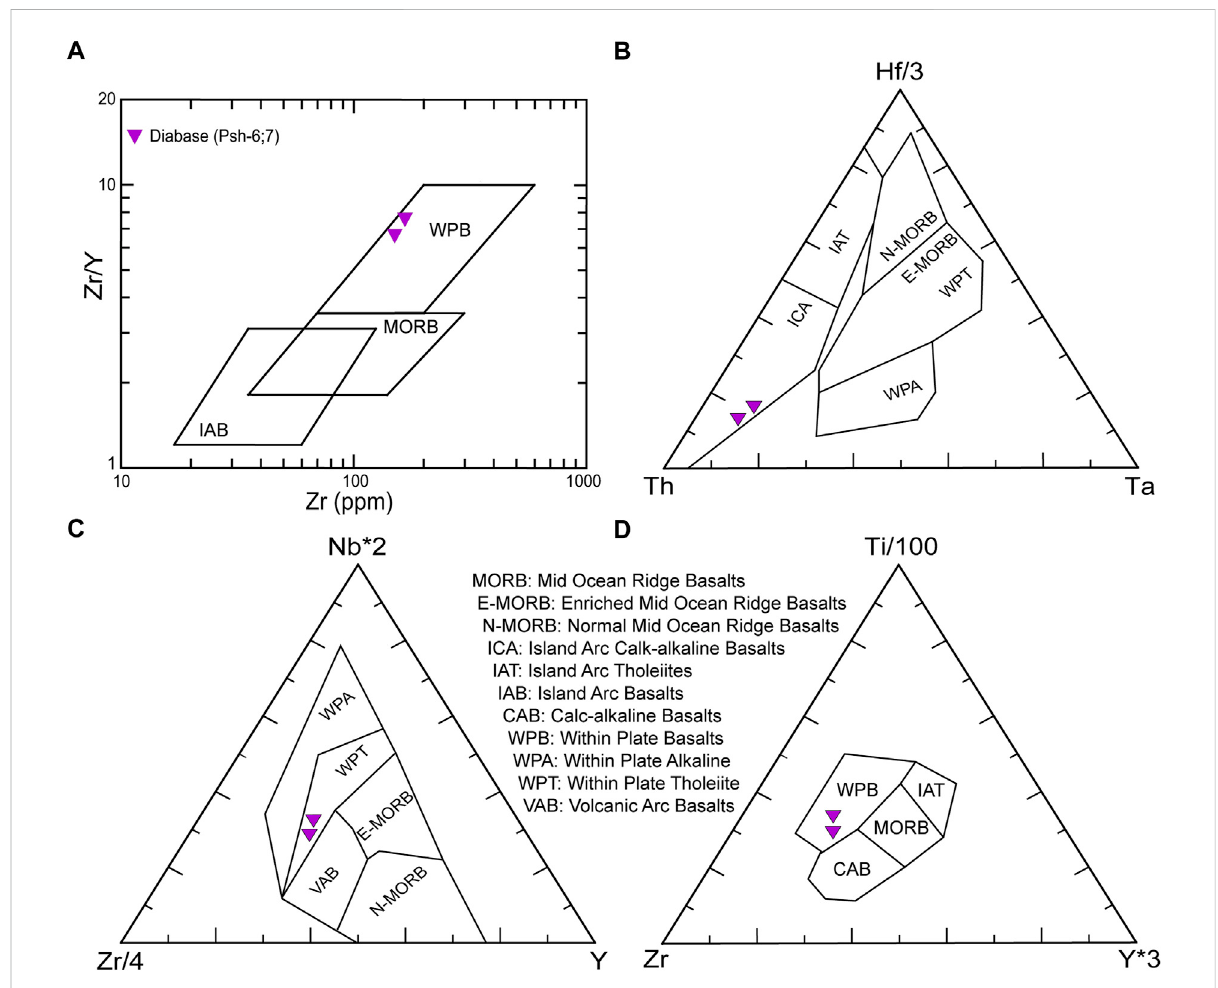
FIGURE 12 TectonicsettingdiscriminationdiagramsforthediabasedikesfromKara-Djilga2valley,Pshartcomplex. (A) Zr/Yvs.Zr(ppm)(PearceandNorry, 1979); (B) Th-Ta- Hf/3 (Wood, 1980); (C) Nb*2- Zr/4-Y (Meschede, 1986); and (D) Zr-Y*3-Ti/100 (Pearce and Cann,